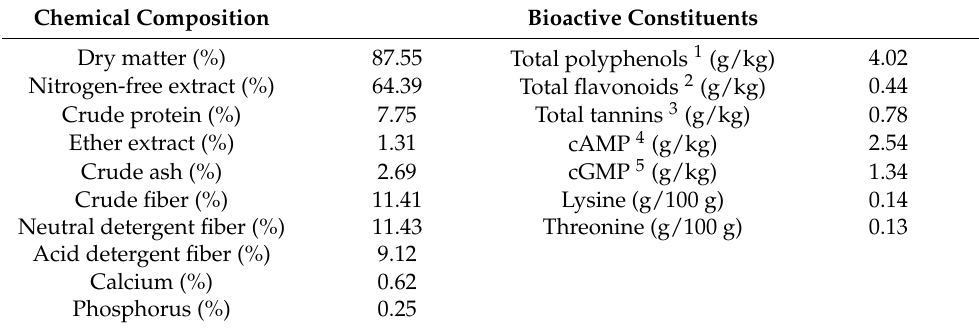
Table 2. Chemical composition and bioactive constituents of dried jujube powder (as-dry basis). Chemical